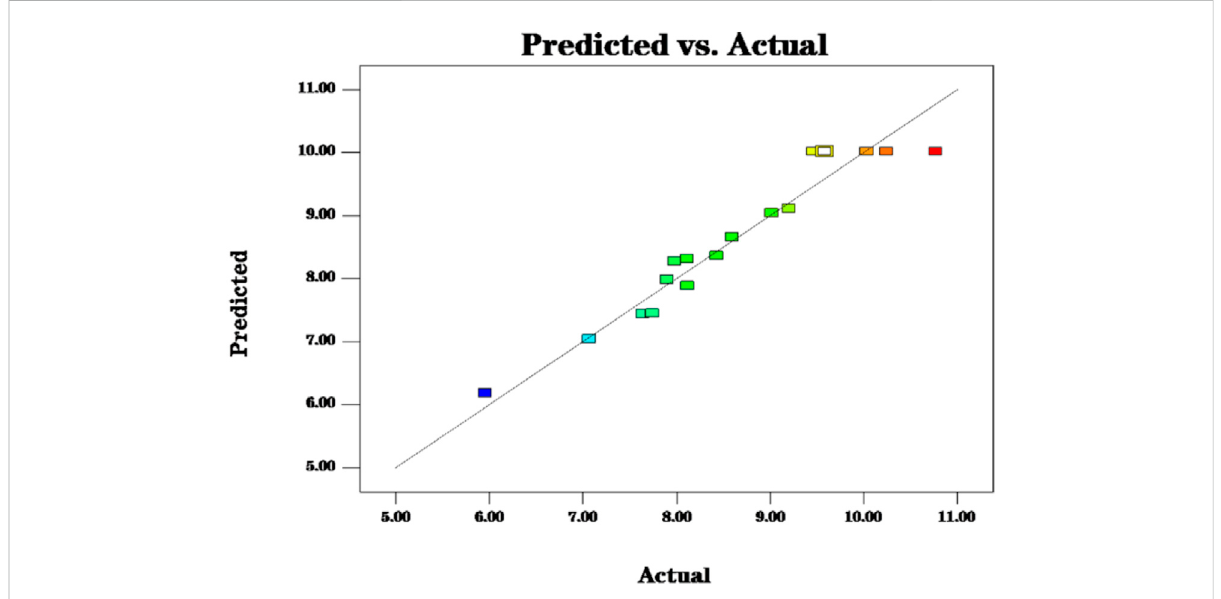
FIGURE 2 The model predictions are consistent with the actual values and the model predictions are